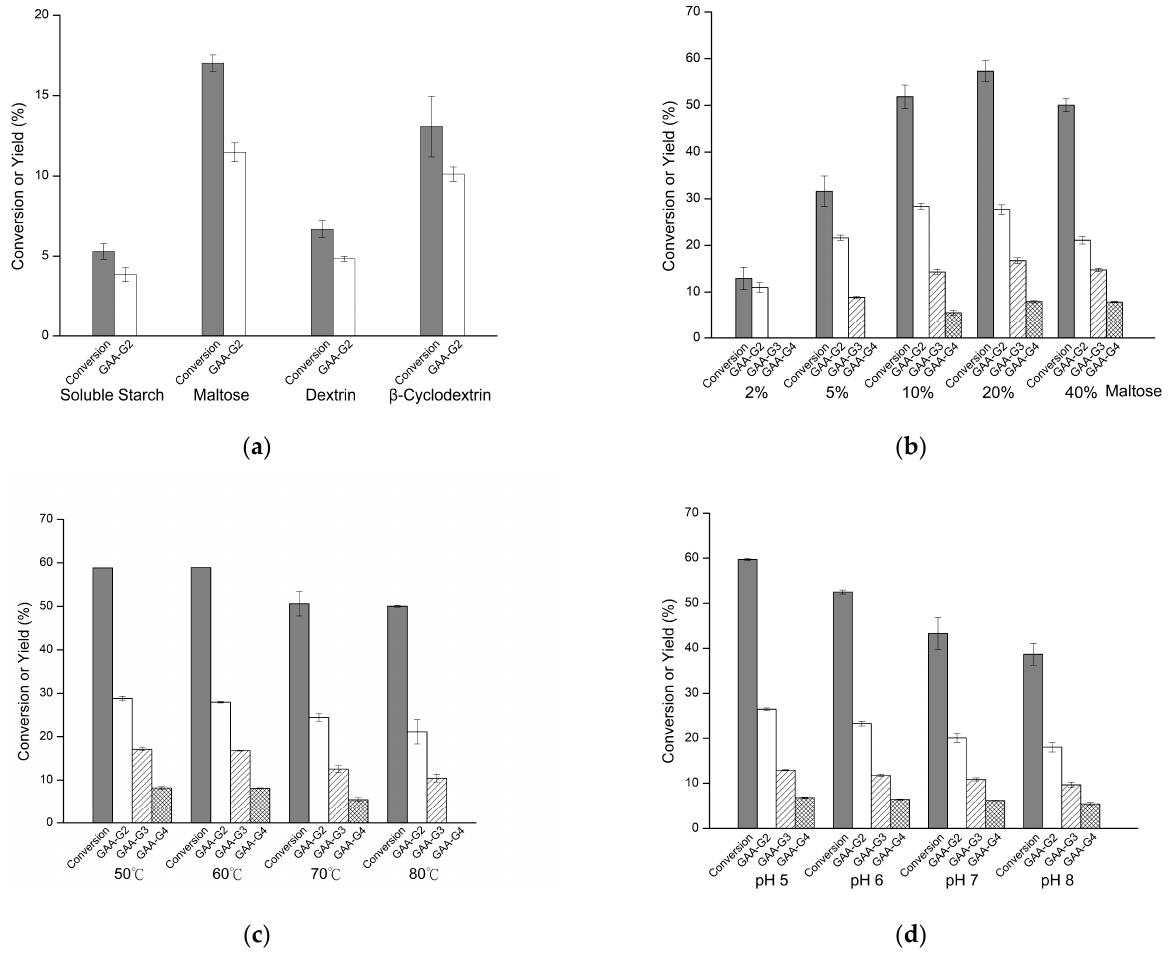
Figure 2. Effects of different sugars ( a ), maltose concentrations ( b ), pH ( c ), and temperatures ( d ) on glycosylation activity of Toruzyme® toward GAA-15-G. The first biotransformation of GAA was performed by 20 μ g/ml of BtGT_16345 at 30 ℃ for 30 min in the presence of 10 mM of PB pH 7.4; 1 mg/ml of GAA; and 10 mM of UDP-G. Then, equal volume of 50 mM of acetate buffer at pH 5 containing 0.3 KNU/ml Toruzyme® and 2% (w/v) of tested sugar was added to start the second biotransformation at 60 °C for 4 hr. The control reaction was conducted without adding Toruzyme®. The optimal reaction condition was determined by checking the reaction under different sugars, maltose concentrations, pH values, and temperature conditions. The conversion was calculated by (1–residue) *100%, where residue was obtained by dividing the peak area of GAA-15-G in the reaction in the HPLC profile by that of the GAA-15-G in the control reaction. The yields of the products were obtained by dividing the area of the product peak of the reaction in the HPLC profile by that of the GAA-15-G peak at the control reaction. The results are presented as mean values ± standard deviations (n = 3).